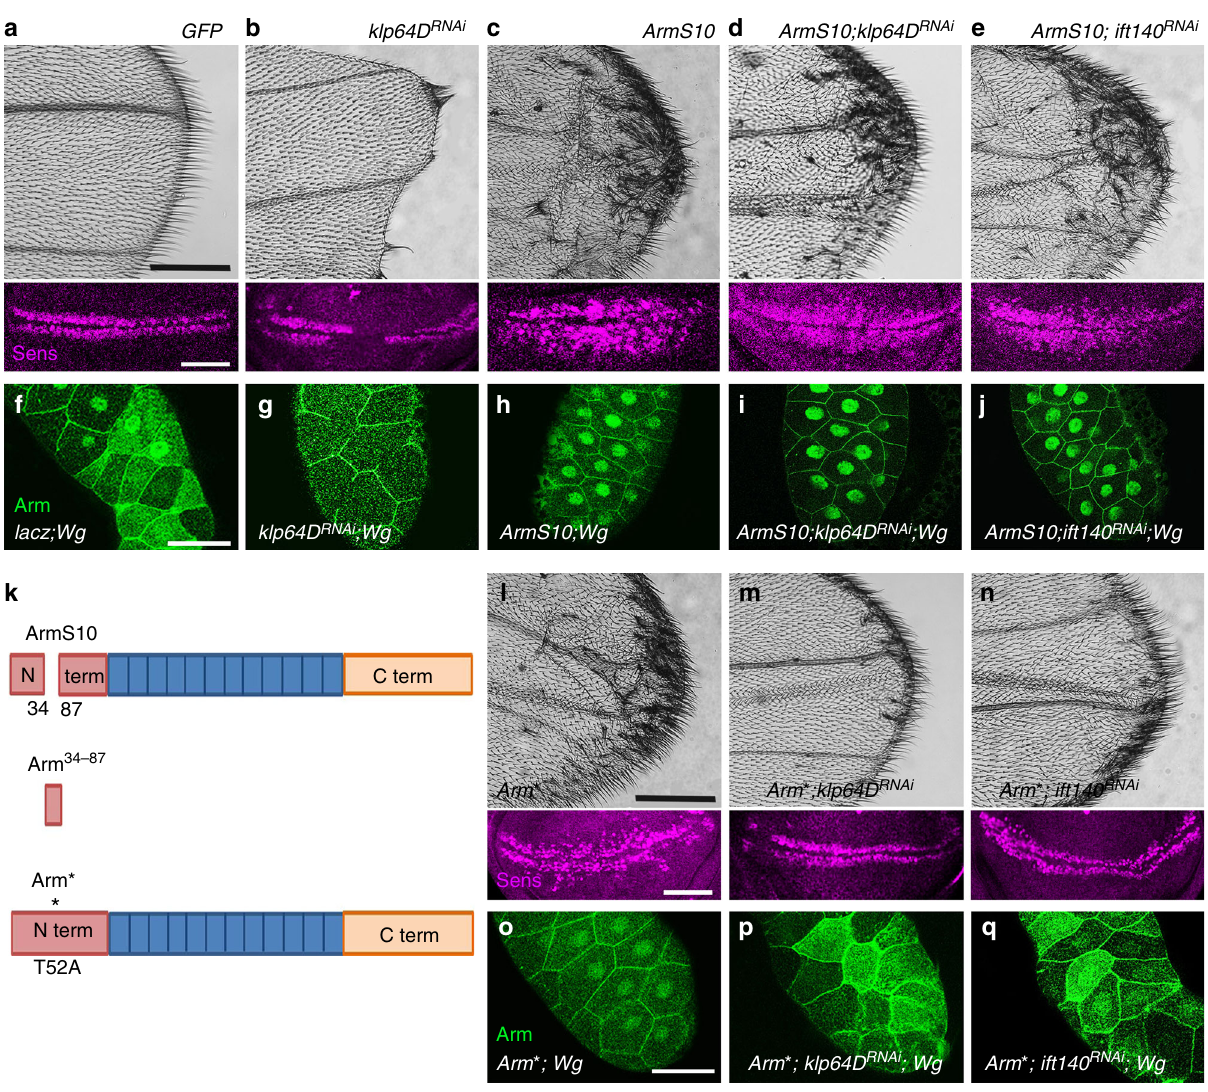
Fig. 6 Stable Arm vs. ArmS10 behavior with respect to Kinesin-2/IFT-A complex function. Panels ( a − e ) and ( l − n ) show distal regions of adult wings (top) and D/V margin in wing discs of same genotypes (bottom). Anti-Sens (magenta in bottom panels) marks future margin bristles. f − j and o − q show salivary glands with C805-Gal4, UAS-Wg ; anti-Arm in green ( f − j and o − q serves also as cellular outline due to jucntional staining. a C96 > GFP wing (control),